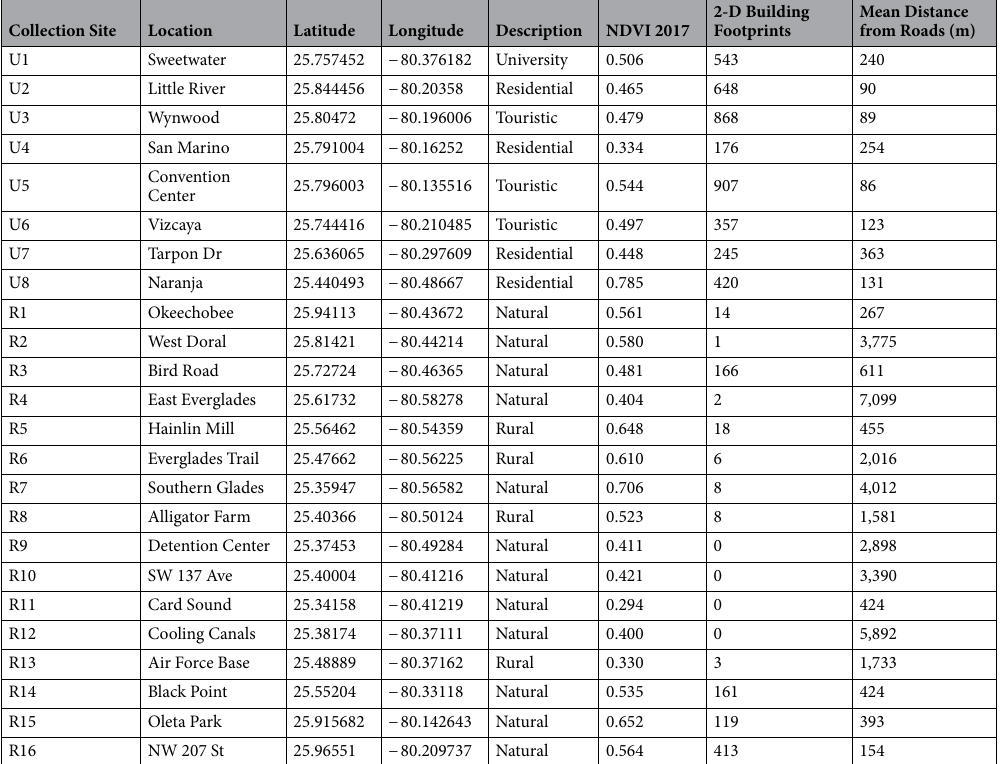
Table 3. Description of the remote and urban collection sites in Miami-Dade,